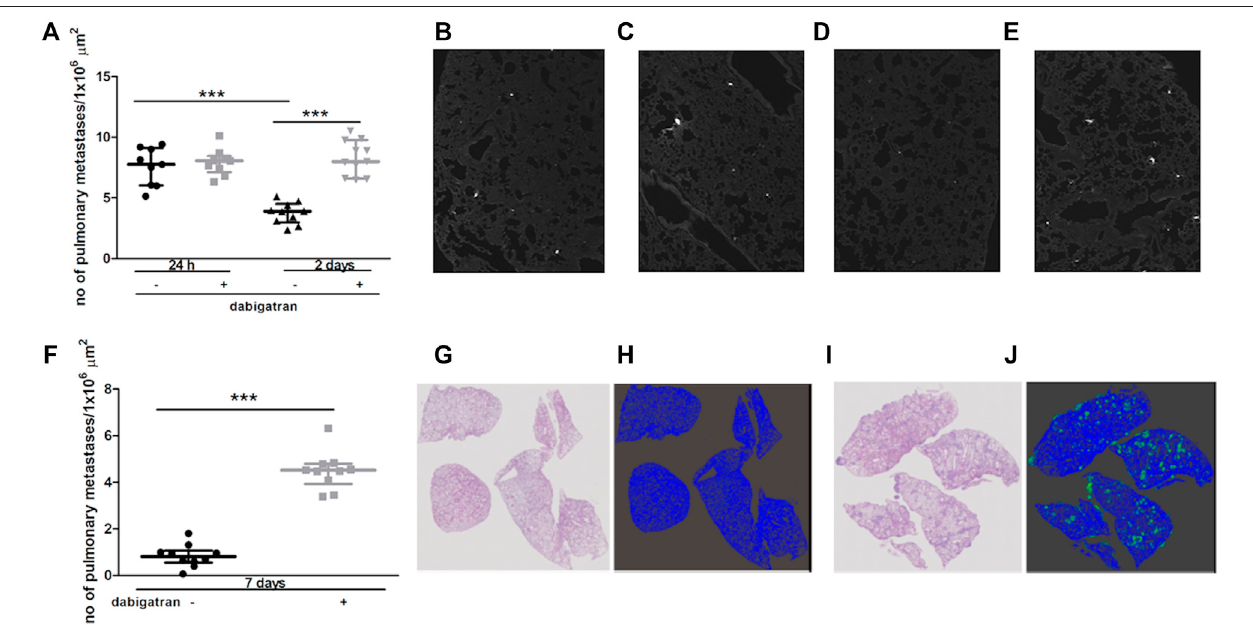
FIGURE1| Effectsofdabigatranonpulmonarymetastasisof4T1breastcancercellsinjectedintravenouslyintoBALB/cmice.Miceweretreatedwithvehicle(black symbols) or dabigatran etexilate (grey symbols) as described in Section 2.5 , injected with 4T1 breast cancer cells, and euthanized 24 h, 2 days, and 7 days after injection.In (A) quantitativeanalysisofpulmonarymetastasisinmice,basedonCellTrackerRed fl uorescenceinmurinelungsisolatedfromanimals24 hand2 daysafter injection of 4T1 cancer cells, is shown. The representative pictures of lung parenchyma illustrating metastatic count in untreated mice 24 h and 2 days after i.v. injection(100x)areshownin (B,D) ,respectively;therepresentativeimagesofdabigatran-treatedmice24 hand2 daysafterinjectionareshownin (C,E) ,respectively.In (F) ,quantitative analysisofpulmonarymetastasisbasedonhaematoxylin andeosin(H&E)staining7 daysafteri.v.injectionisshown.TherepresentativeimagesofH&E- stained lung cross-sections (100×) of mice not treated and treated with dabigatran etexilate are shown in (G,I) , respectively, while the results of Ilastik segmentation of (G,I) are shown in (H,J) (blue: lung parenchyma, green: pulmonary metastases), respectively. Statistical analysis in (A) was performed using a two-way ANOVA